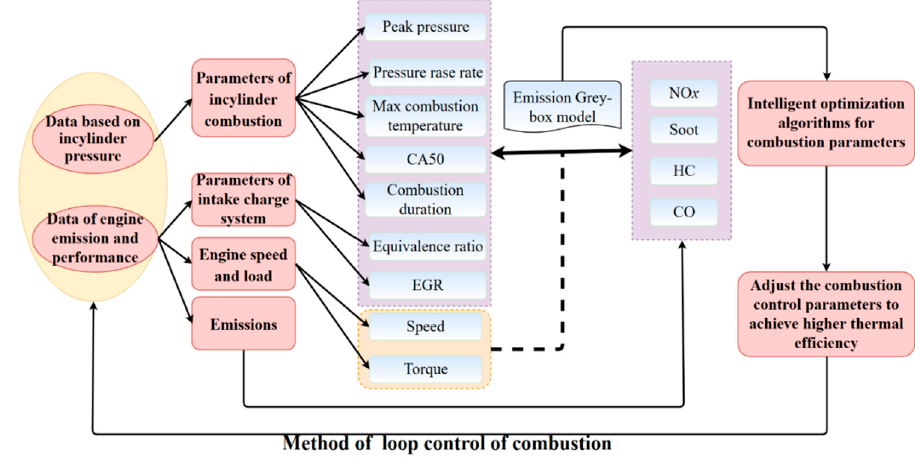
Figure 2. Diagram of combustion loop control algorithm.